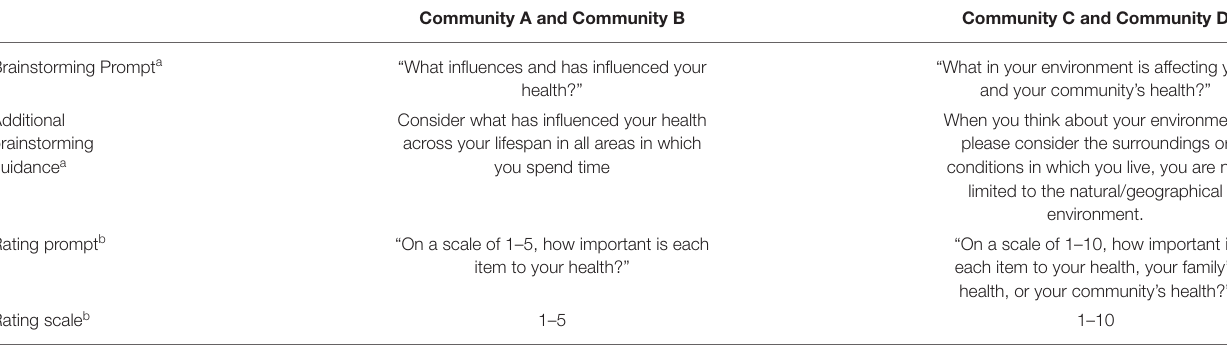
TABLE 2 | Brainstorming and rating details for each